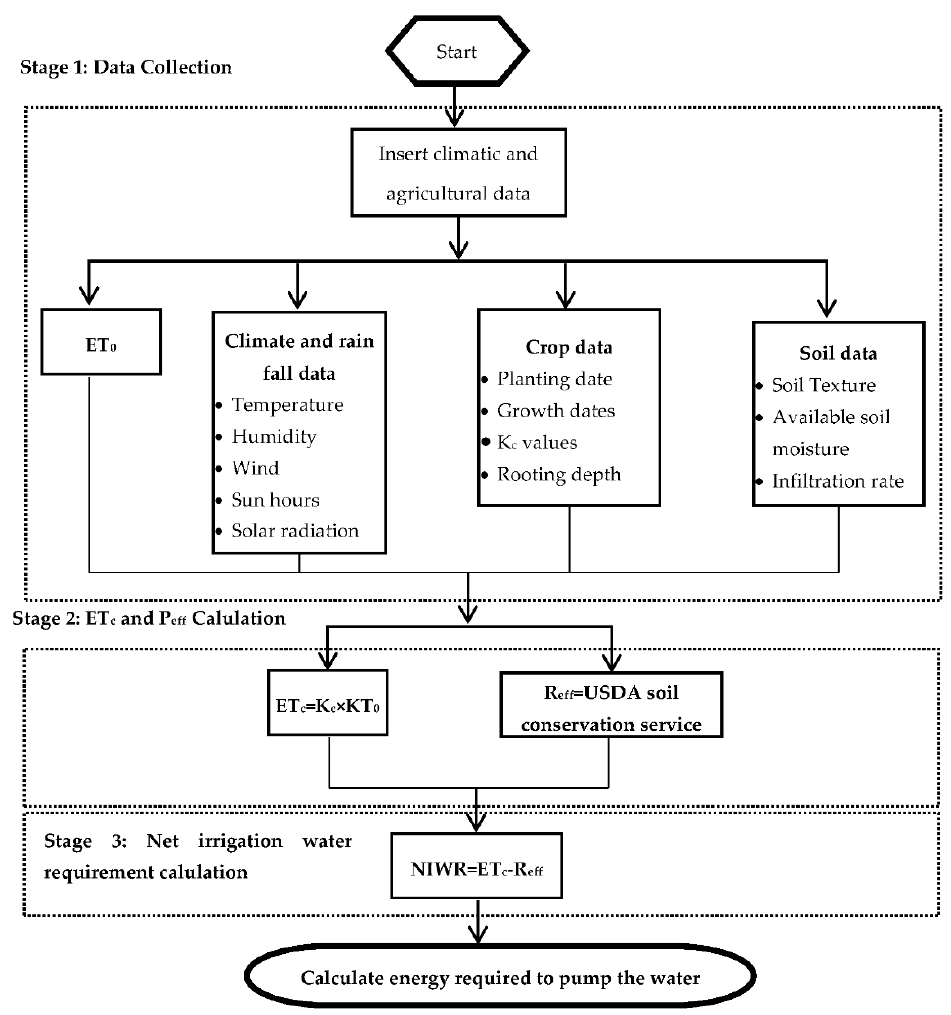
Figure 4. Flow chart for the crop water requirement and energy calculation [12].